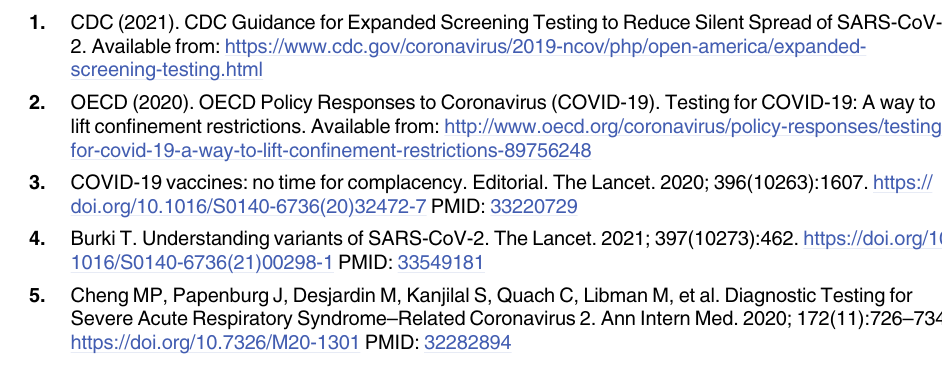
S1 Table. Mean and 90th percentile of the number of lost infection-days by screening plan (A1, A2, B1, B2, C, D), under different epidemic scenarios ( R tests have sensitivity 0.7 and maximum specificity. S2 Table. Mean and 90th percentile of the number of lost infection-days by screening plan (A1, A2, B1, B2, C, D), under different epidemic scenarios ( R tests have sensitivity 0.9 and maximum